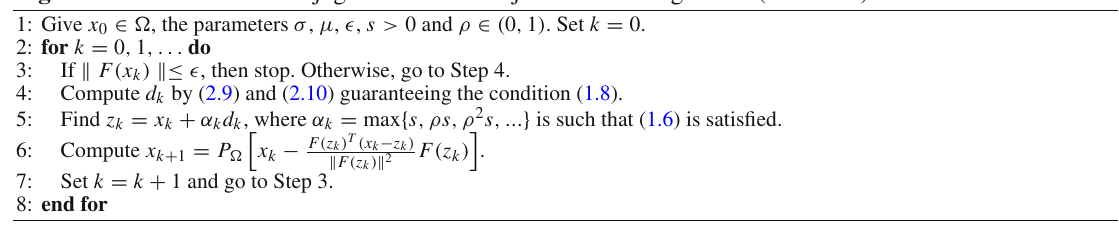
Algorithm 1 Three-term Conjugate Gradient Projection based algorithm